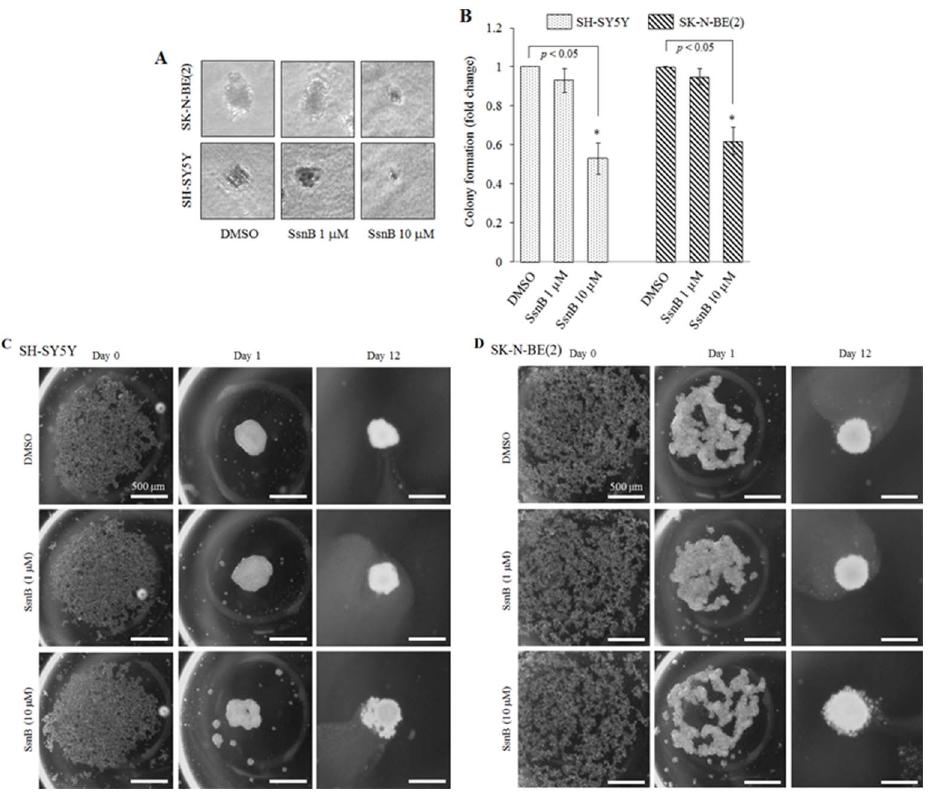
Figure 6. SsnB reduces the tumorigenicity of neuroblastoma cells. Phase contrast images showing neuroblastoma colonies formed after treatment with SsnB (1 and 10 m M) for 45 days in anchorage-independent agarose gel colony formation assay ( A ). The number of colonies was counted and plotted ( B ). Bar represents mean and S.D. of three independent experiments and * p , 0.05 was considered significant. ( C and D ) SsnB inhibits the neuroblastoma spheroid formation. Phase contrast images showing spheroid formation in absence or presence of SsnB (1 or 10 m M) in 3- D hanging drop assay. Twenty microliter drop containing 20,000 cells (SH-SY5Y, C ; and SK-N-BE(2) cells, D ) were pipetted on the lower side of the lid of petri dish. The lid was gently inverted, placed on top of the petri dish and let them grow at 37 u C. On day 0, day 1 and day 12 the image of cells in each droplet was taken by Olympus inverted microscope to monitor the spheroid formation. Scale bar=500 m m.